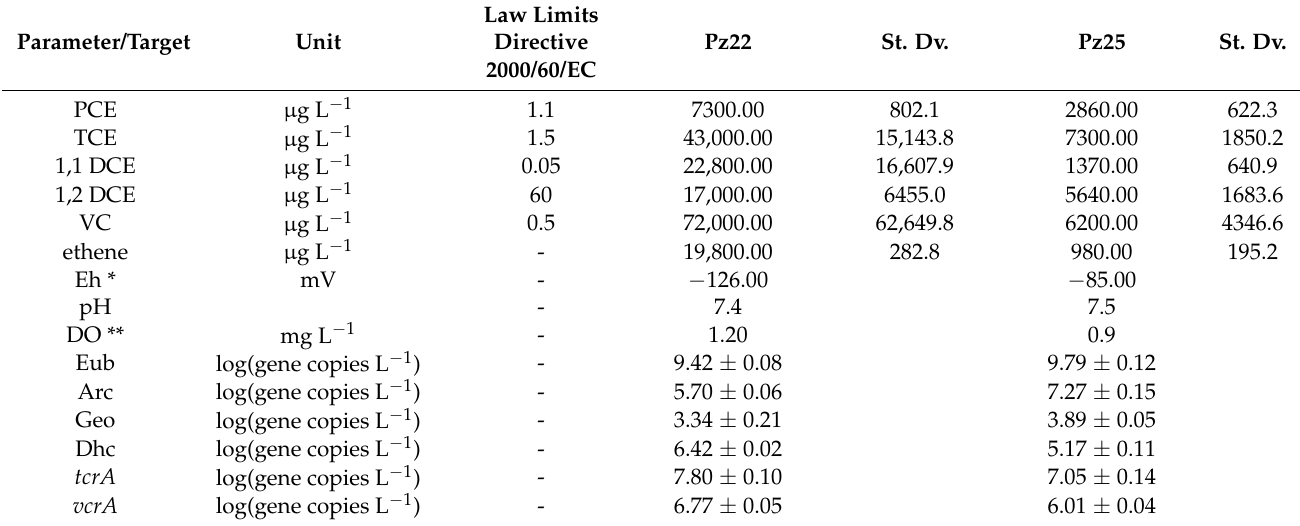
Table 1. Chemical parameters and OHR biomarkers in landfill piezometers at the beginning of the pilot scale experiment. Parameter/Target Unit